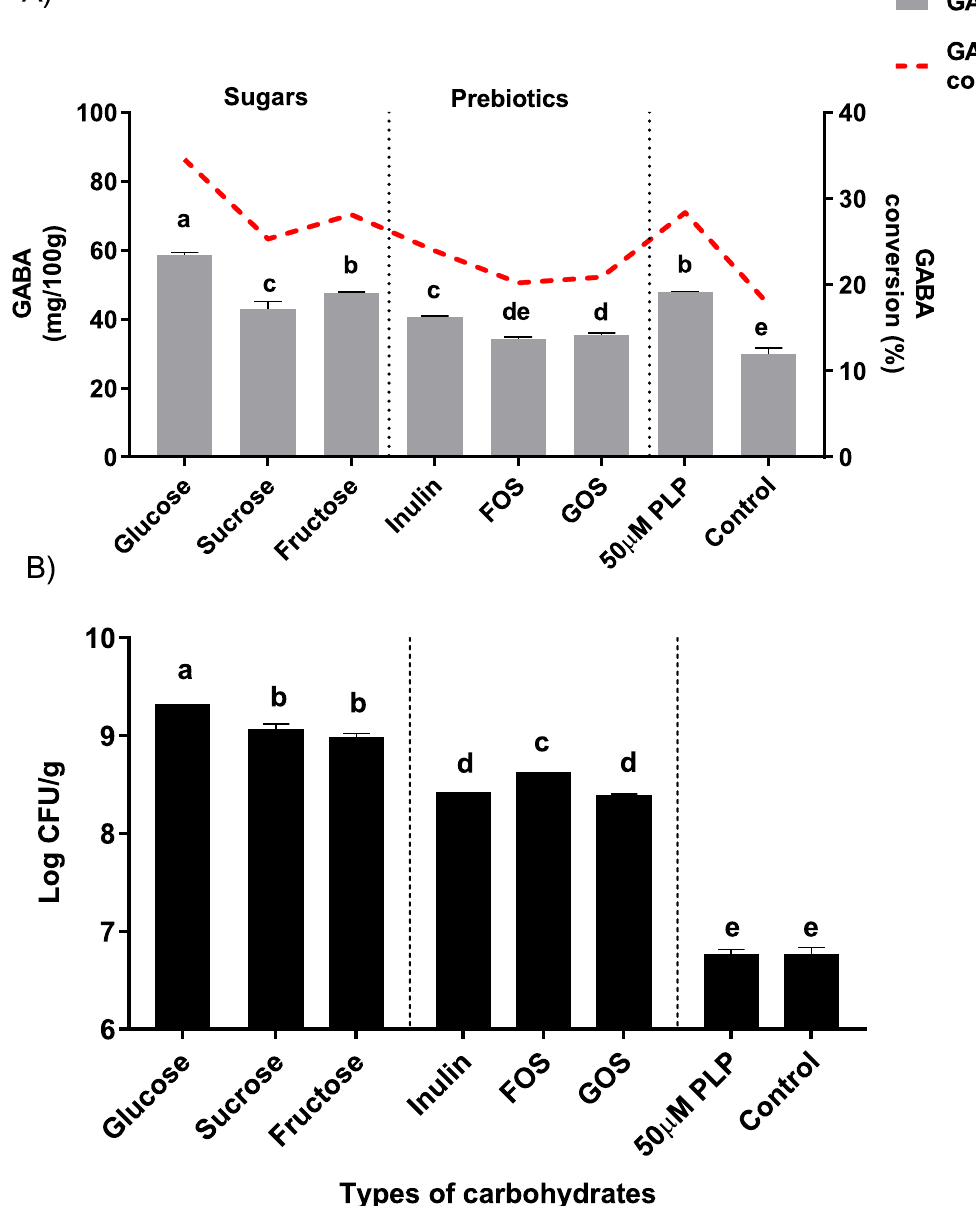
Figure 1. Effect of simple carbohydrates on ( A ) GABA content and conversion rate and ( B ) Viable cell count in yoghurt. Different letters indicate significant difference at p <